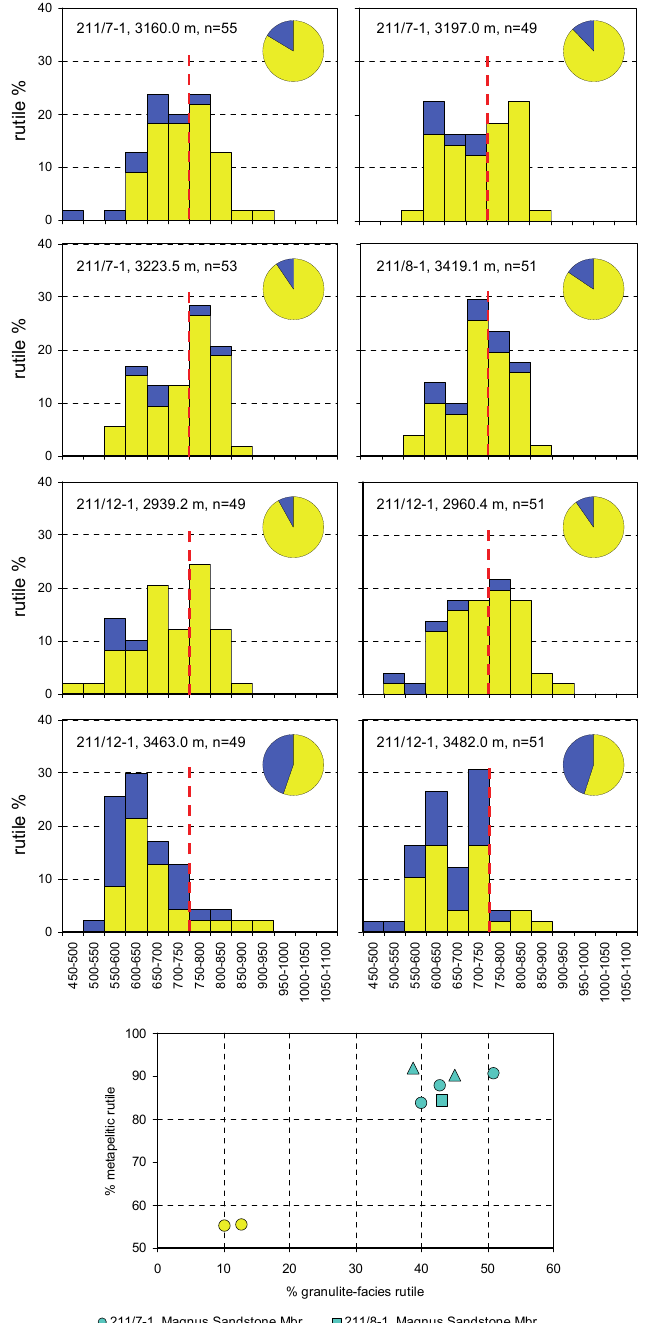
Figure 11. Discrimination of Magnus and Ptarmigan sandstones using rutile trace element geochemistry. Magnus rutile populations are dominated by metapelitic types and include a high proportion that formed in high-grade granulite facies conditions, whereas Ptarmigan sandstones have much higher proportions of metamafic types and lack evidence for high-grade metamorphism. Categorisation of metamafic and metapelitic rutiles uses Cr and Nb contents as defined by Meinhold et al. [63]. Crystallisation temperatures were determined using Zr contents following Watson et al.